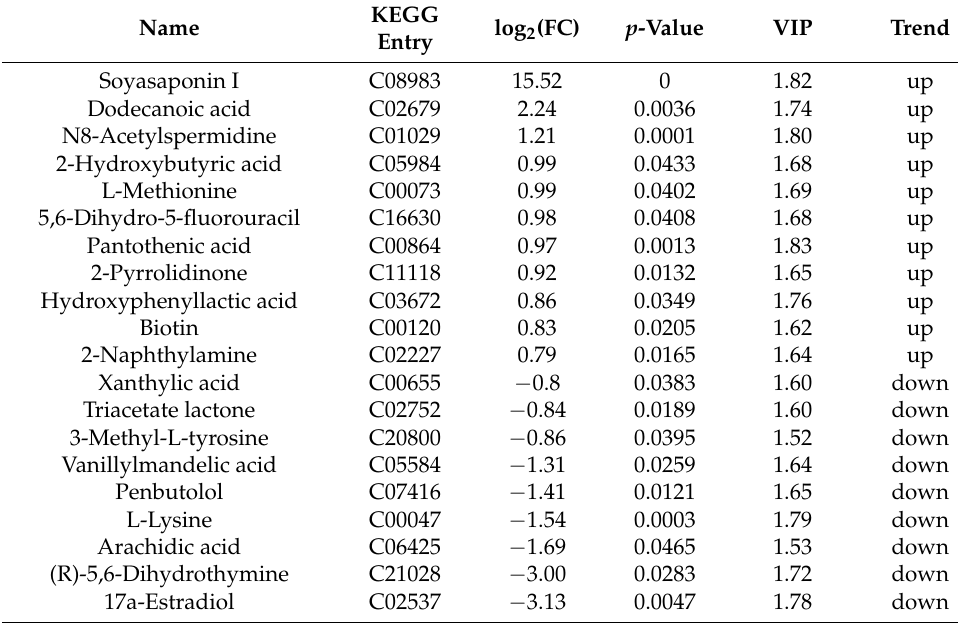
Table 1. The top 20 DAMs with the largest absolute value of log 2